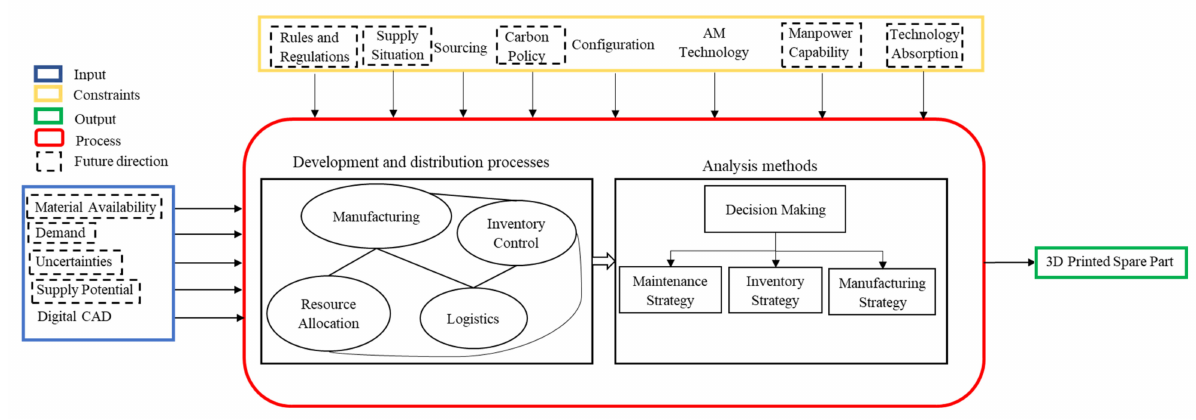
Figure 3. Proposed areas of research directions are indicated in dashed